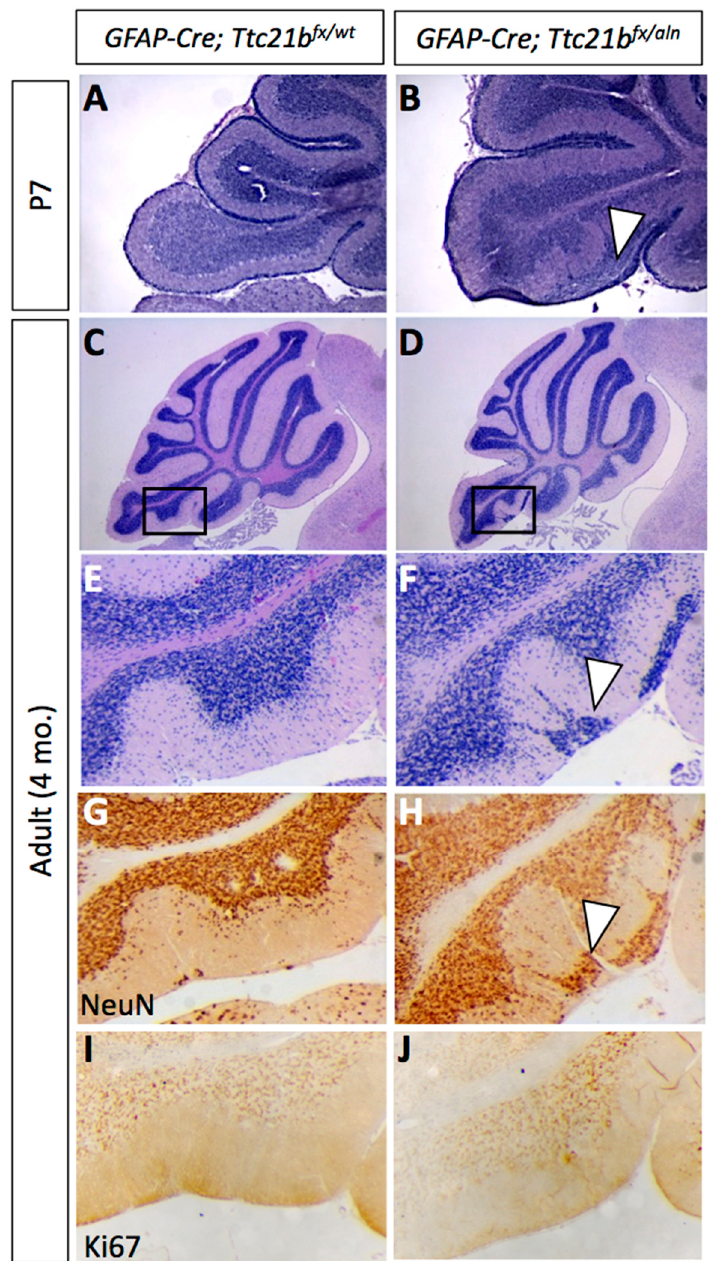
Figure 2. Ablation of Ttc21b from astrocytes results in ectopic granule cells in the cerebellum. H&E staining at P7 ( A , B ) and 4 months of age ( C – F ) show granule cells present in the outer layers of the cerebellum of GFAP-Cre;Ttc21b fx / aln animals which are not found in controls (n > 4). NeuN immunoreactivity indicates that these ectopic cells are differentiated granule cells ( G , H , arrowheads). Ki67 immunostaining for proliferative cells is negative in adults ( I , J ), suggesting that these are not proliferating tumors. n ≥ 4 for adult histology, n ≥ 3 for adult DAB staining and P7 histology.